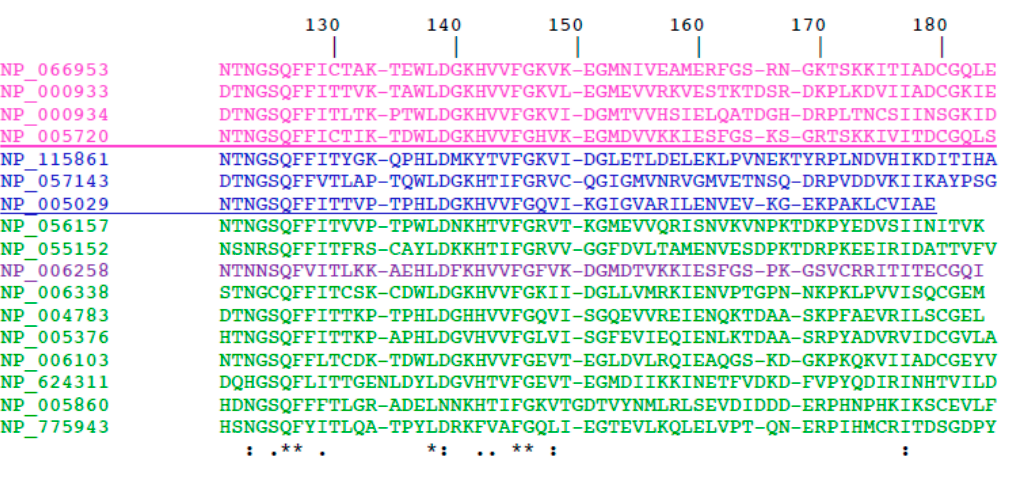
Figure 2. Matrix of human cyclophilin used for construction of heat-map. 1—Cyclophilin-As (CyP-